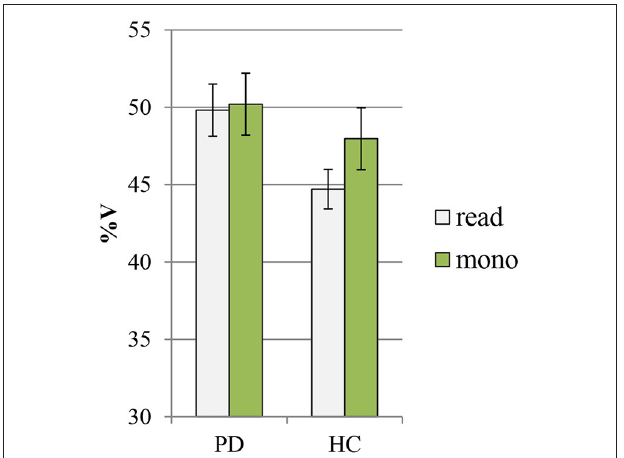
in the case of monolog in patients with PD with speech difficulties ( p =